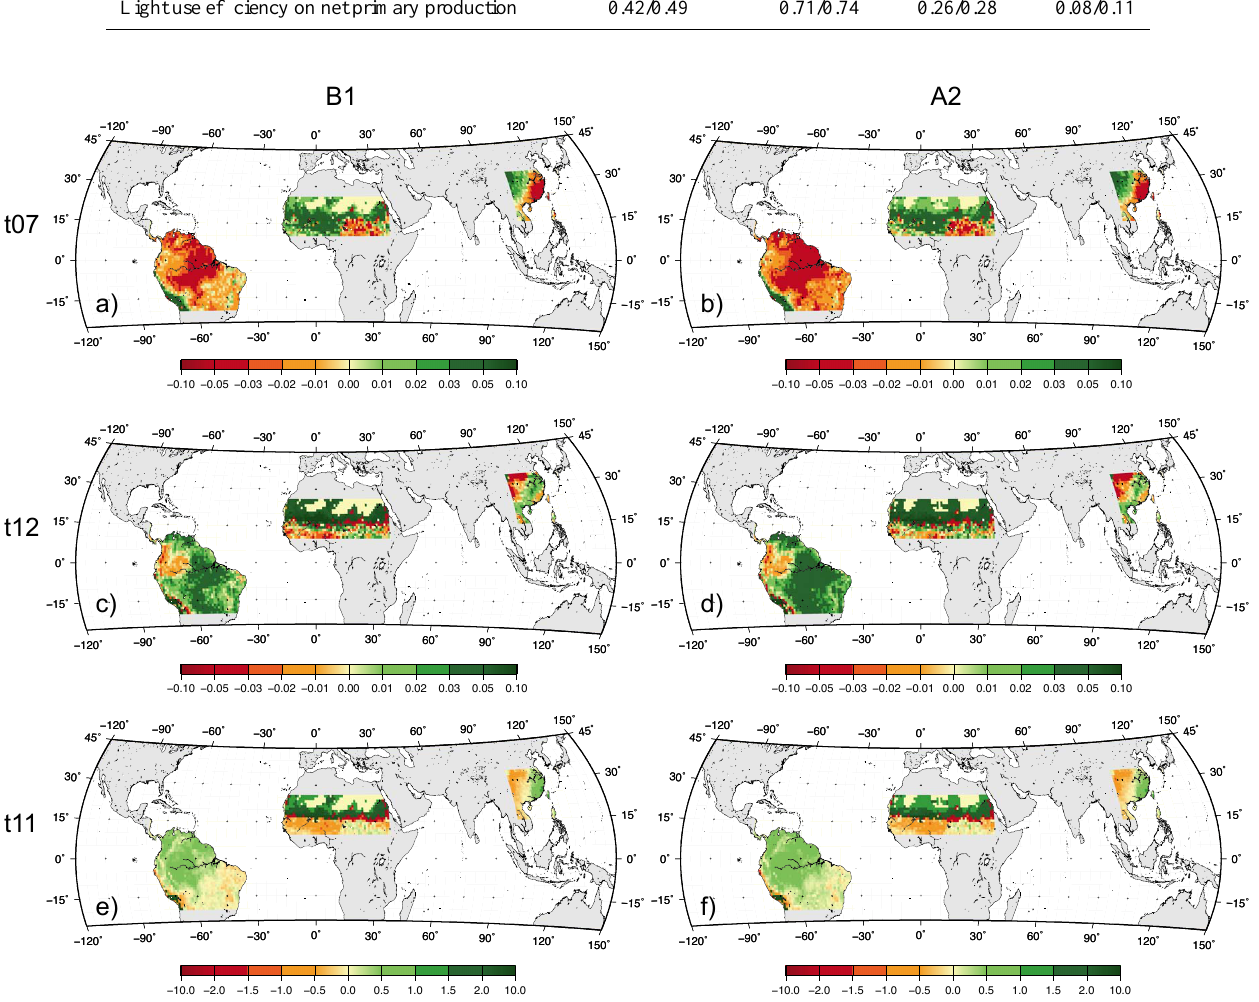
Fig. 4. Mean shifts in the plant functional traits “allocation to above-ground structure [fractional]” (t07; a, b ), “light use efficiency on net primary production [fractional]” (t12; c, d ) and “seed size [gCper seed]” (t11; e, f ) between present-day and the climate scenarios (B1, A2). Values are expressed as the mean change in the respective plant functional trait across plant growth strategies (PGS) per grid cell.